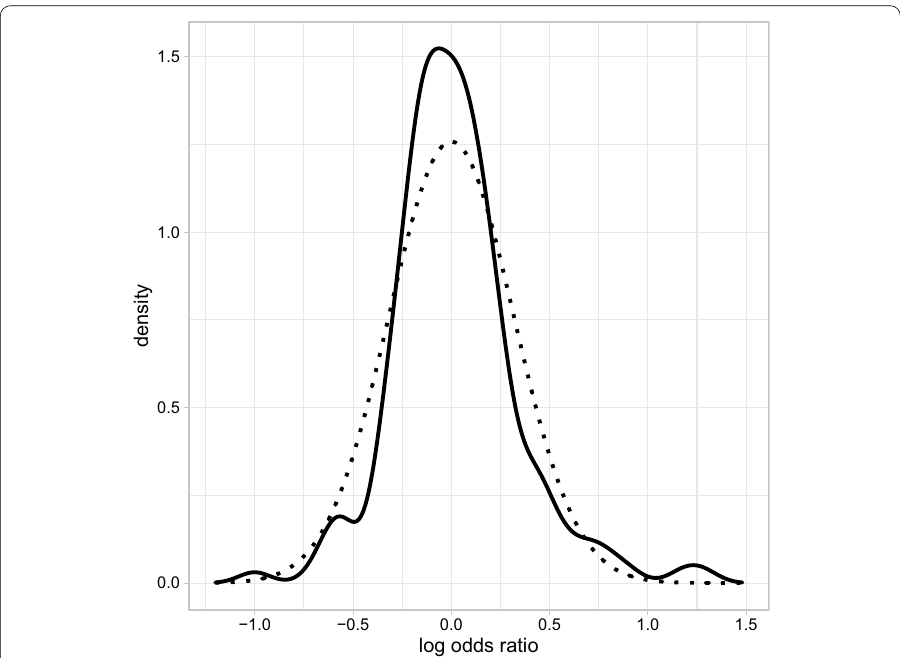
Fig. 1 Comparison of the no‑effect and the sample log odds ratio distributions by language (full dotted no‑effect) =